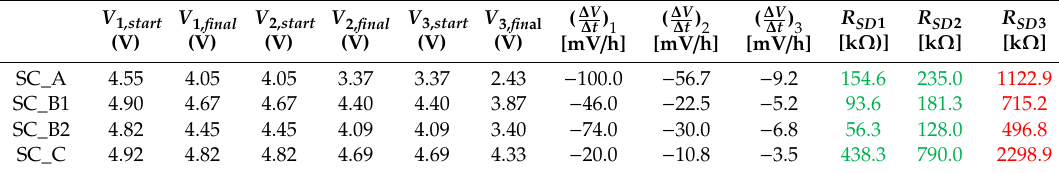
Table 3. Summarizing table with SCs’ self-discharge rates, expressed in mV/h, and self-discharge R SD resistance calculated for the three considered time intervals (SCs charged at 5 V and kept under charge for five hours).